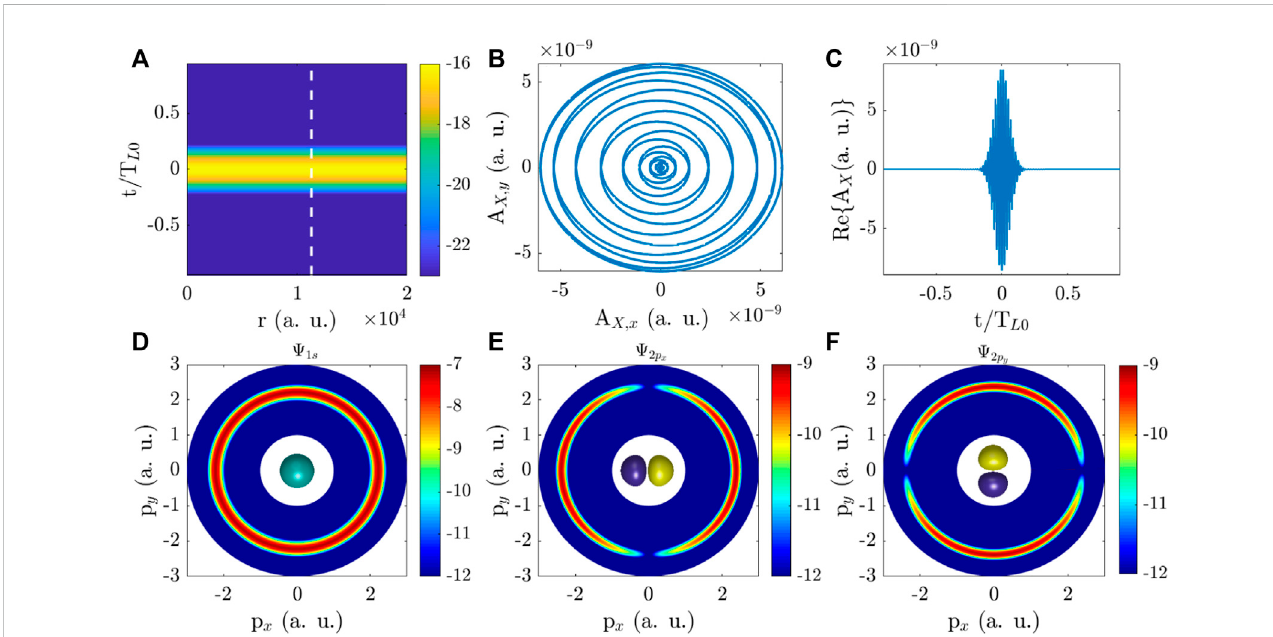
A X A X r , x - , y plane atposition 0 . (C) Realpartofthepulse